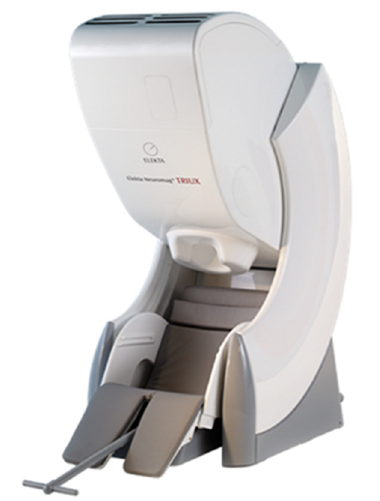
Figure 1. MEGIN Elekta Neuromag TRIUX MEG system with 306 SQUID sensors with an integrated 128 channel EEG. A state-of-the-art system with high tolerance for magnetic interference, improved subject comfort and zero Helium boil off. Reprinted from [29] (Copyright 2011 Elekta Oy).